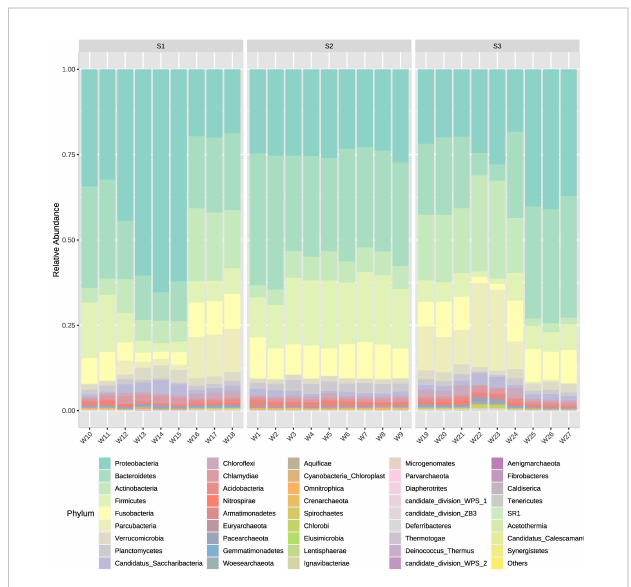
FIGURE 3 Mean relative abundances of all bacterial phyla present in water out fl ow, water in fl ow and sediment samples from three different systems: intensive, semi-intensive and extensive. The lateral axis shows the sample names, and the vertical axis shows the relative abundance of each phyla.